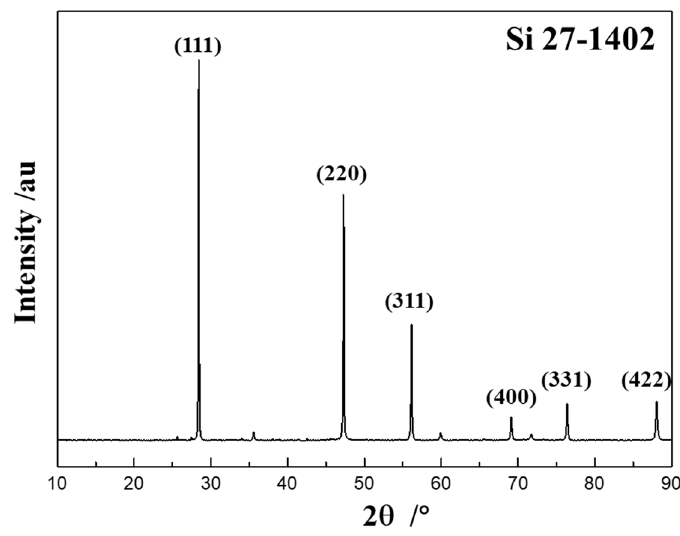
Figure 4. XRD pa tt ern of the Si layer sprayed using the parameter of P0. Figure 4. XRD pattern of the Si layer sprayed using the parameter of P0.